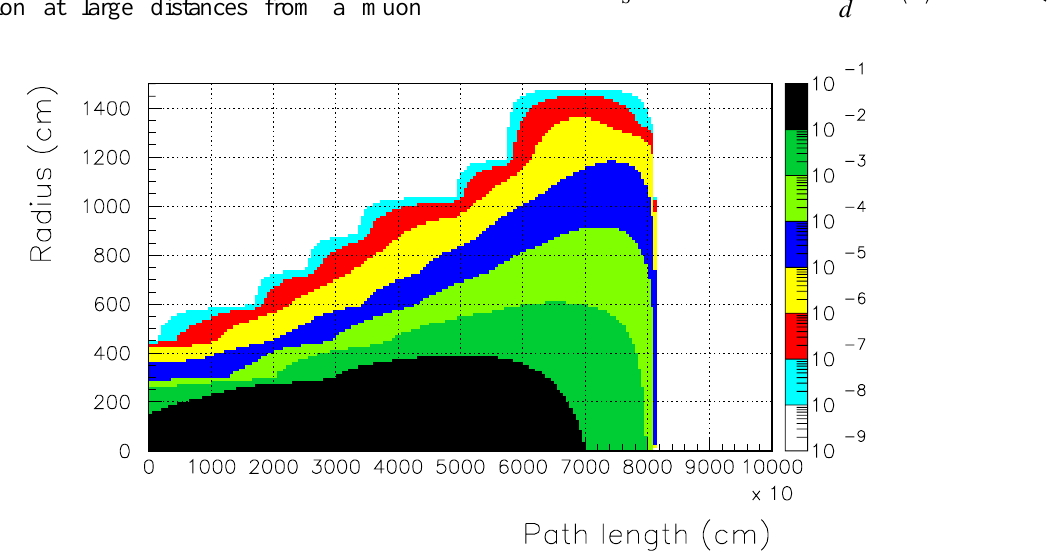
FIG. 61. (Color) Isodose contours in the soil/rock ( r (cid:1) 2.24 g (cid:1) cm 3 ) for 250 GeV muons extracted at 3 3 10 13 per second. Right- hand scale is dose rate in rem (cid:1)